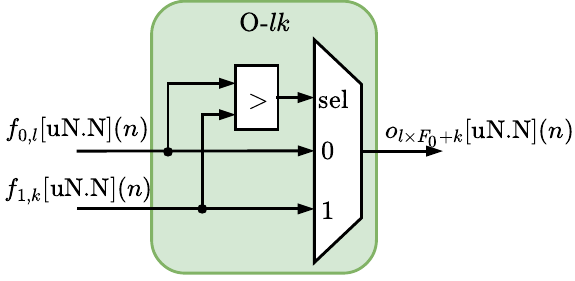
Figure 8. Arquitecture of the module O- lk associated with the operation between the fuzzyfied signal from the l -th membership function from input 0, f 0, l [ nN.N ]( n ) , with the k -th membership function from input 1, f 1, k [ uN.N ]( n ) (see Equation